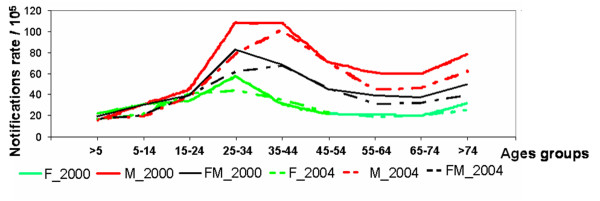
Notification rates (/105) per age group and gender, for 2000 and 2004.